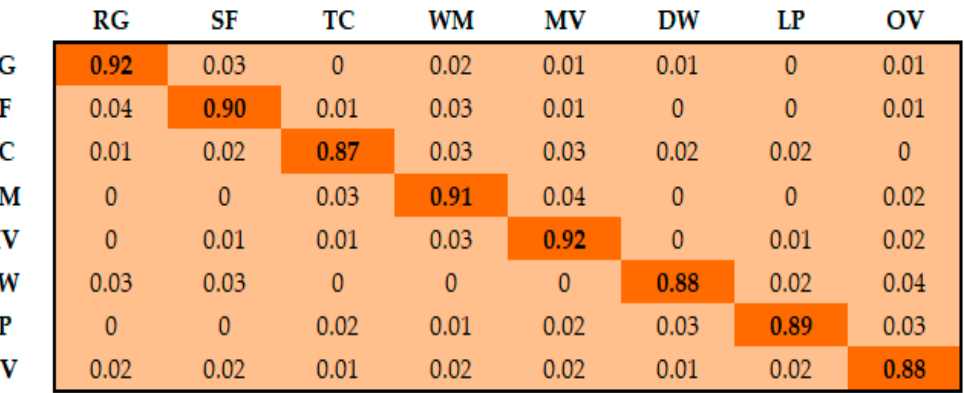
Figure 15. Confusion matrix D3D-HOI dataset, RG = refrigerator, SF = storage furniture, TC = trashcan,